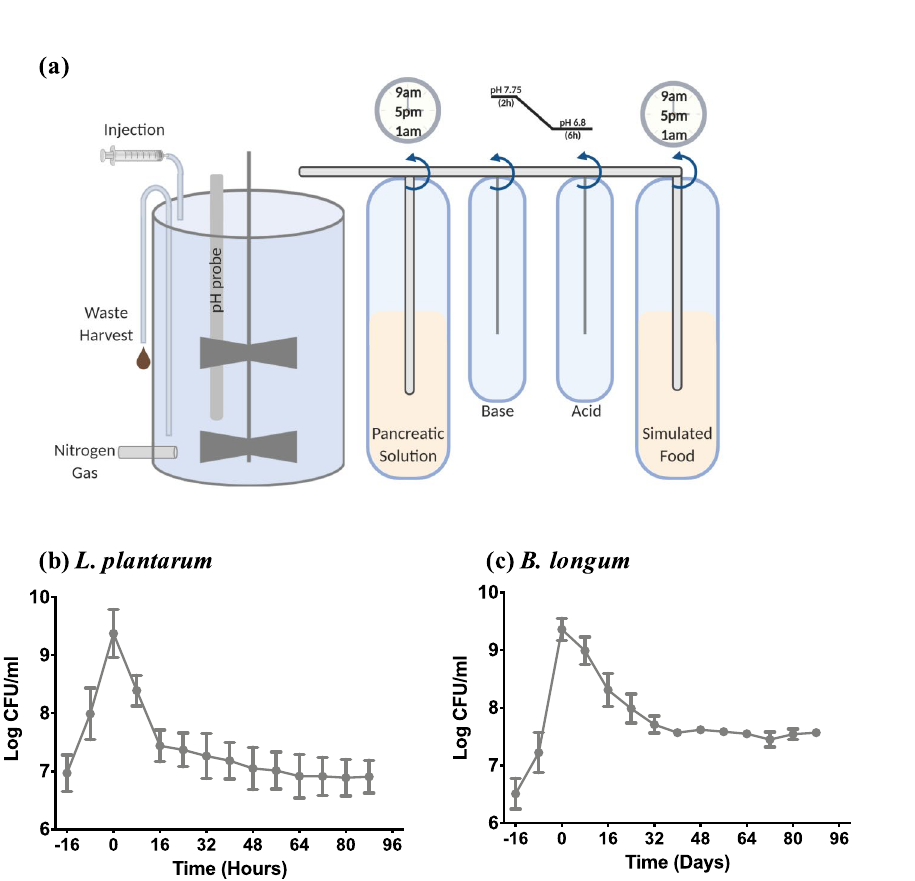
Figure 1. A novel ex vivo gastrointestinal model can maintain typical commensal cultures. A schematic of ( a ) A Bioreactor Imitation of Microbiota Ecosystem (ABIOME) shows the main bioreactor unit being connected to a computer controlled pumping system from each of the input solutions: pancreatic solution, base, acid and simulated “food”. The food and pancreatic solution inputs are controlled as a thrice-daily feed cycles while the acid and base maintain the pH set-points of the bioreactor at a pre-set ramp rate. With the feeding cycles, there is a thrice daily “waste harvest” where a portion of the bioreactor contents is removed to circulate wastes. The bioreactor unit is kept under strict anaerobic conditions via constant nitrogen sparging while the contents are constantly agitated by the stirring system. Using this system of feeding and pH control, monocultures of ( b ) the aerobic L. plantarum and ( c ) anaerobic B. longum reached a steady-state level after several hours of incubation. Cultures were inoculated in the food source at − 16, − 8 and 0 h, emulating the thrice daily feeding, after which the maintenance of the cultures was observed for 88 h. Cultures were enumerated with serial dilutions and plating on MRS and MRS-cysteine plates, respectively, following calculation of the number of colony forming units (CFU) per milliliter. Each time point represents n = 3 independent trials +/−